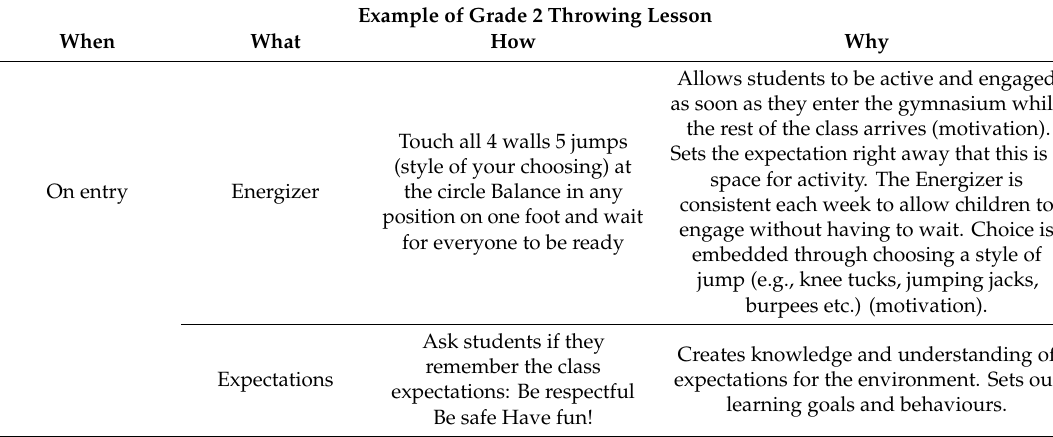
Table 2. Example of a Grade 2 throwing lesson, including components related to why each activity was chosen in relation to the knowledge development of the teacher and the connections to